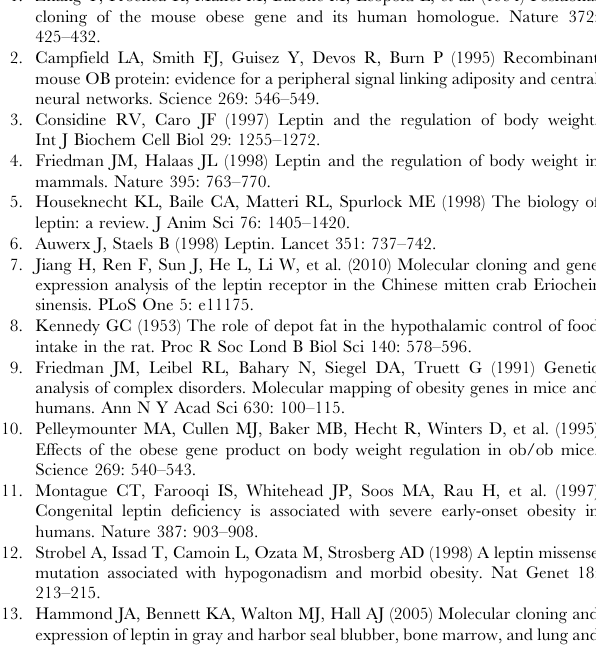
Table S1 List of taxonomic samples and sequences used in this study Table S2 PAML results for branches a-p except for branch b and m in Figure